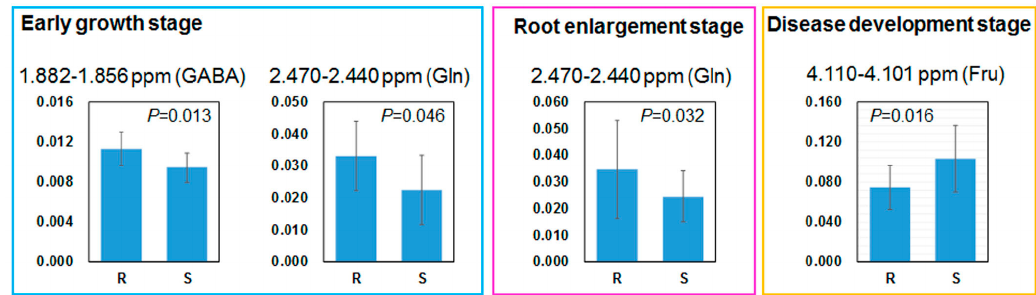
Figure 3. Relative intensity of the isolated NMR regions annotated to 4-aminobutyrate (GABA) (1.882–1.856 ppm) and glutamine (Gln) (2.470–2.440 ppm) at the early growth stage, Gln at the root enlargement stage, and Fru (4.316–4.290 ppm) at the disease development stage. S: susceptible group; and R: resistant group.